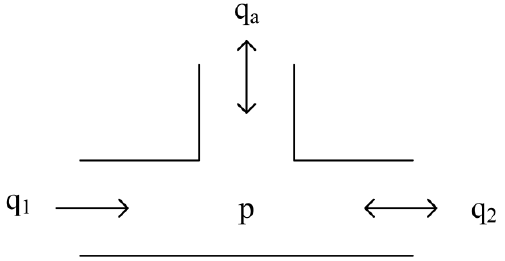
Figure 5. Flow directions within the high-pressure hose of the